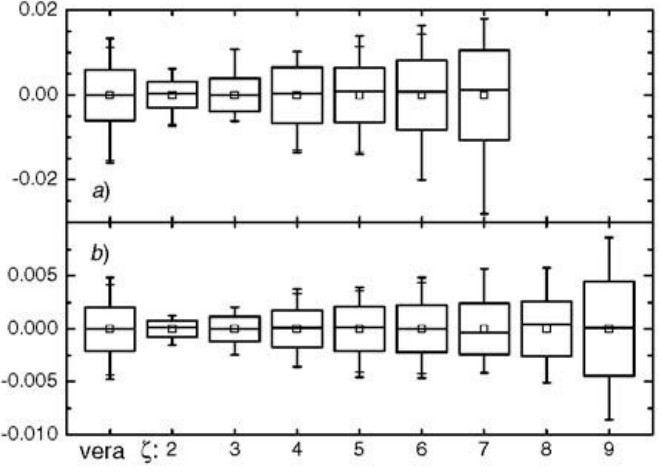
Figura 6 – Andamento della distribuzione dell’esponente di Lyapunov massimo dell’attrattore di Rössler ottenuto ricampionando 100 volte un’unica serie pulita ( a ) e contaminata ( b ) in funzio- ne del fattore (cid:93) , per cui è diviso l’intervallo di misura originale. I parametri sono gli stessi di figu- ra 3. L’altezza della scatola è pari a 2 volte l’errore standard e i “baffi” indicano il minimo e